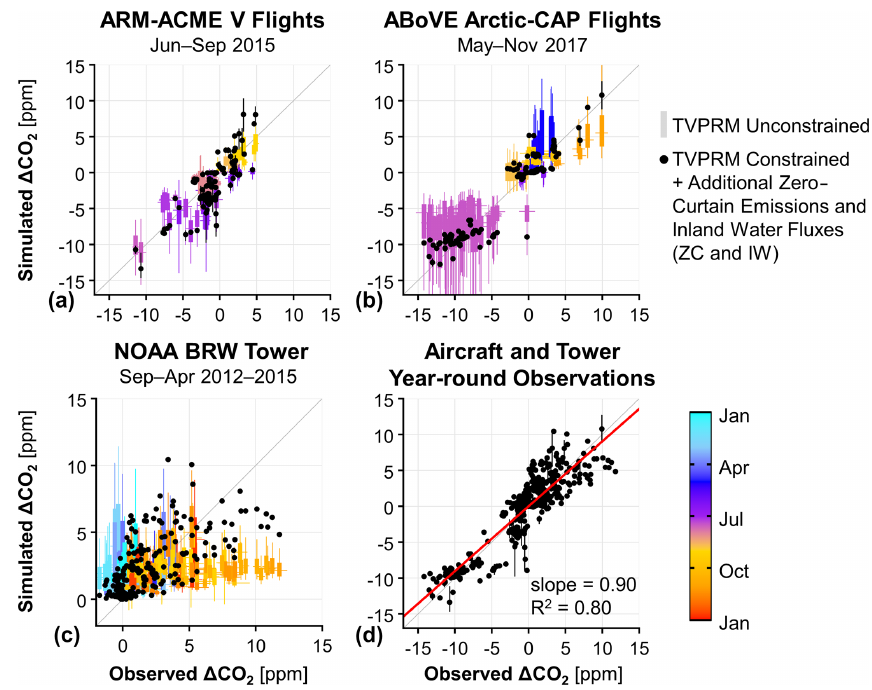
Figure 2. Aircraft and tower CO 2 concentration measurements constrain year-round simulated CO 2 fluxes on the Alaska North Slope. (a– c) Comparison of observed and simulated (cid:49) CO 2 during the ARM-ACME V flight campaign (a) , during the ABoVE Arctic-CAP flight campaign (b) , and at the NOAA BRW tower (c) for air over the Alaska North Slope. Horizontal lines indicate the range of uncertainty in the NOAA BRW tower ocean-sector background calculation. Vertical boxes colored by month of the year represent 50% and whiskers represent 95% of the (cid:49) CO 2 values from all members of the unconstrained TVPRM ensemble (see Sect. 2.4) from all binned points. Black points show values from the constrained TVPRM member with additional zero-curtain (ZC) emissions and inland water (IW) fluxes (see Sect. 3.4). For panels (a) and (b) , observed values are vertically binned medians, and vertical lines contain the middle 95% of (cid:49) CO 2 values from all binned points for the constrained TVPRM member + ZC and IW. (d) Combined comparison of observed and simulated (cid:49) CO 2 for all aircraft and tower points using the constrained TVPRM member + ZC and IW. The linear best fit (red line), the slope determined by ordinary least squares, and the coefficient of determination ( R 2 ) of all points ( n = 455) are shown. The 1 : 1 is line shown in dark